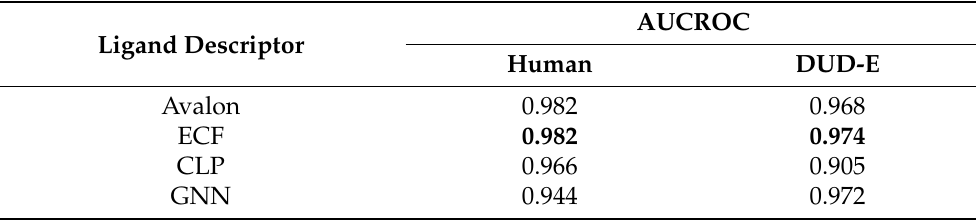
Table 1. Model comparison on the human and DUD-E datasets for various ligand